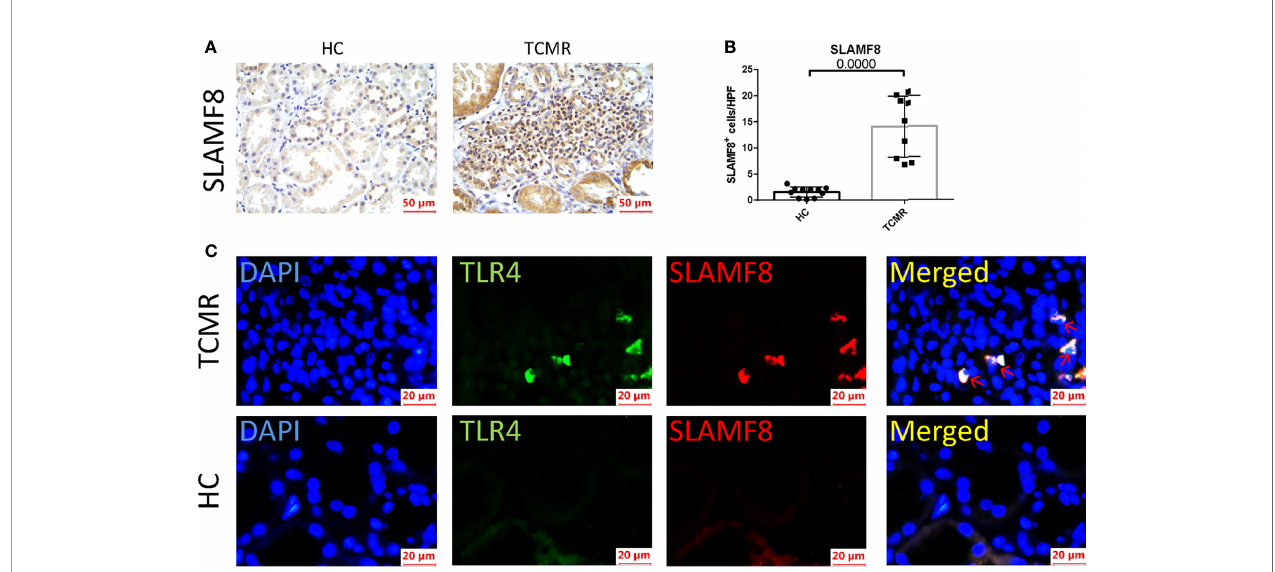
FIGURE 8 | SLAMF8 participate in AR progression via TLR4 in vivo . (A, B) Representative images and quanti fi cation of SLAMF8 + cells number in the human allograft diagnosed as TCMR (n=9) clinically and HC (n=11). Scale bar: 50 m m; six random fi elds were taken from each kidney. (C) Representative of immuno fl uorescence staining of TLR4 (green) and SLAMF8 (red) in TCMR (n=11) and HC (n=8). Red arrow indicates cells co-expressing TLR4 and SLAMF8. Scale bar=20 m m; TCMR, T-cell-mediated rejection; HC, healthy